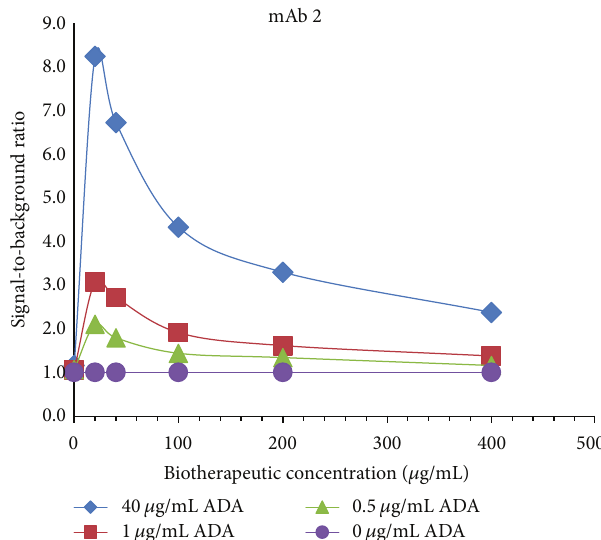
Figure 3: Early development experiments informed on biothera- peutic concentrations to test with a variety of molecules. Signal-to- background ratios obtained in a pooled cynomolgus monkey serum spiked with purified cynomolgus monkey anti-human IgG ADAs at 0, 0.5, 1, and 40 𝜇 g/mL and with mAb 2 at 0, 20, 40, 100, 200, and 400 𝜇 g/mL. The figure shows signal-to-background ratios increase with increasing concentrations of ADA. The highest signal-to-noise was observed at mAb 2 concentration of 20 𝜇 g/mL while higher levels of mAb 2 yielded decrease in the signal-to-noise values at all the ADA levels tested. Based on these data, further experiments with a variety of molecules were performed with biotherapeutic levels up to 20 𝜇 g/mL. ADAs = anti-drug antibodies; ADC = antibody-drug conjugate; mAb = monoclonal antibody.